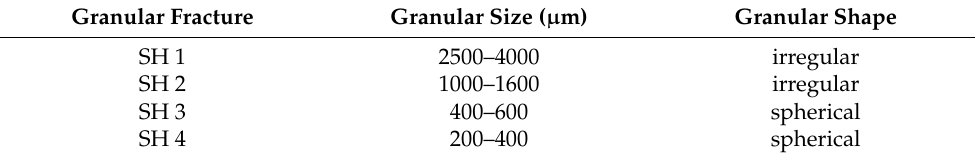
Figure 3. A space holder powder of sodium chloride used in the work: ( a ) irregular shaped and ( b ) spherical shaped. Table 2. Values of compaction index ( K ) addressed to different packing processes. SH—space holder.